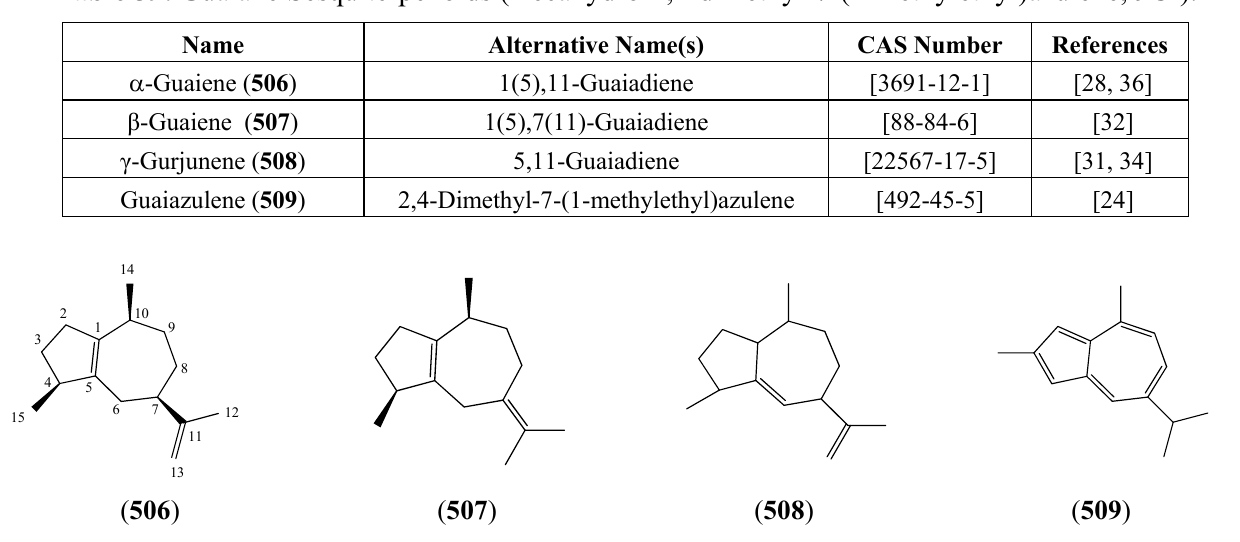
Table 39. Guaiane Sesquiterpenoids (Decahydro-1,4-dimethyl-7-(1-methylethyl)azulene,